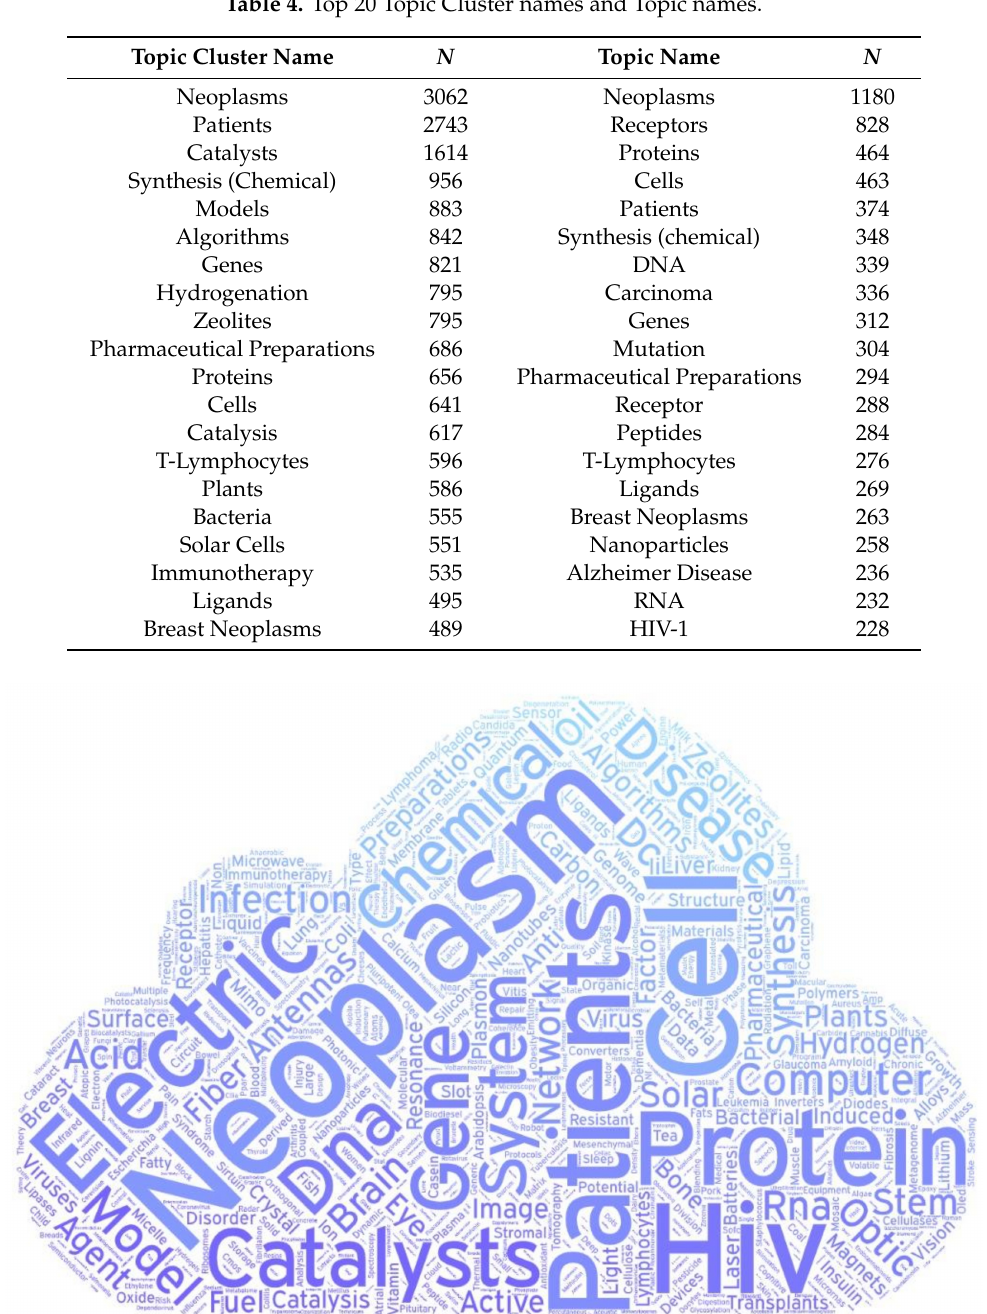
Figure 9. Cloud Word of Topic